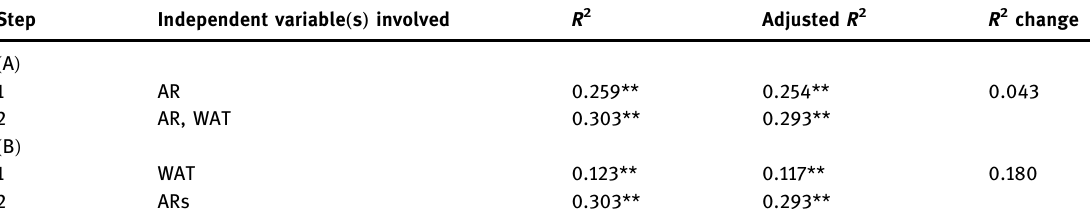
Table 2: Multiple regression analysis of depth of vocabulary knowledge and academic reading